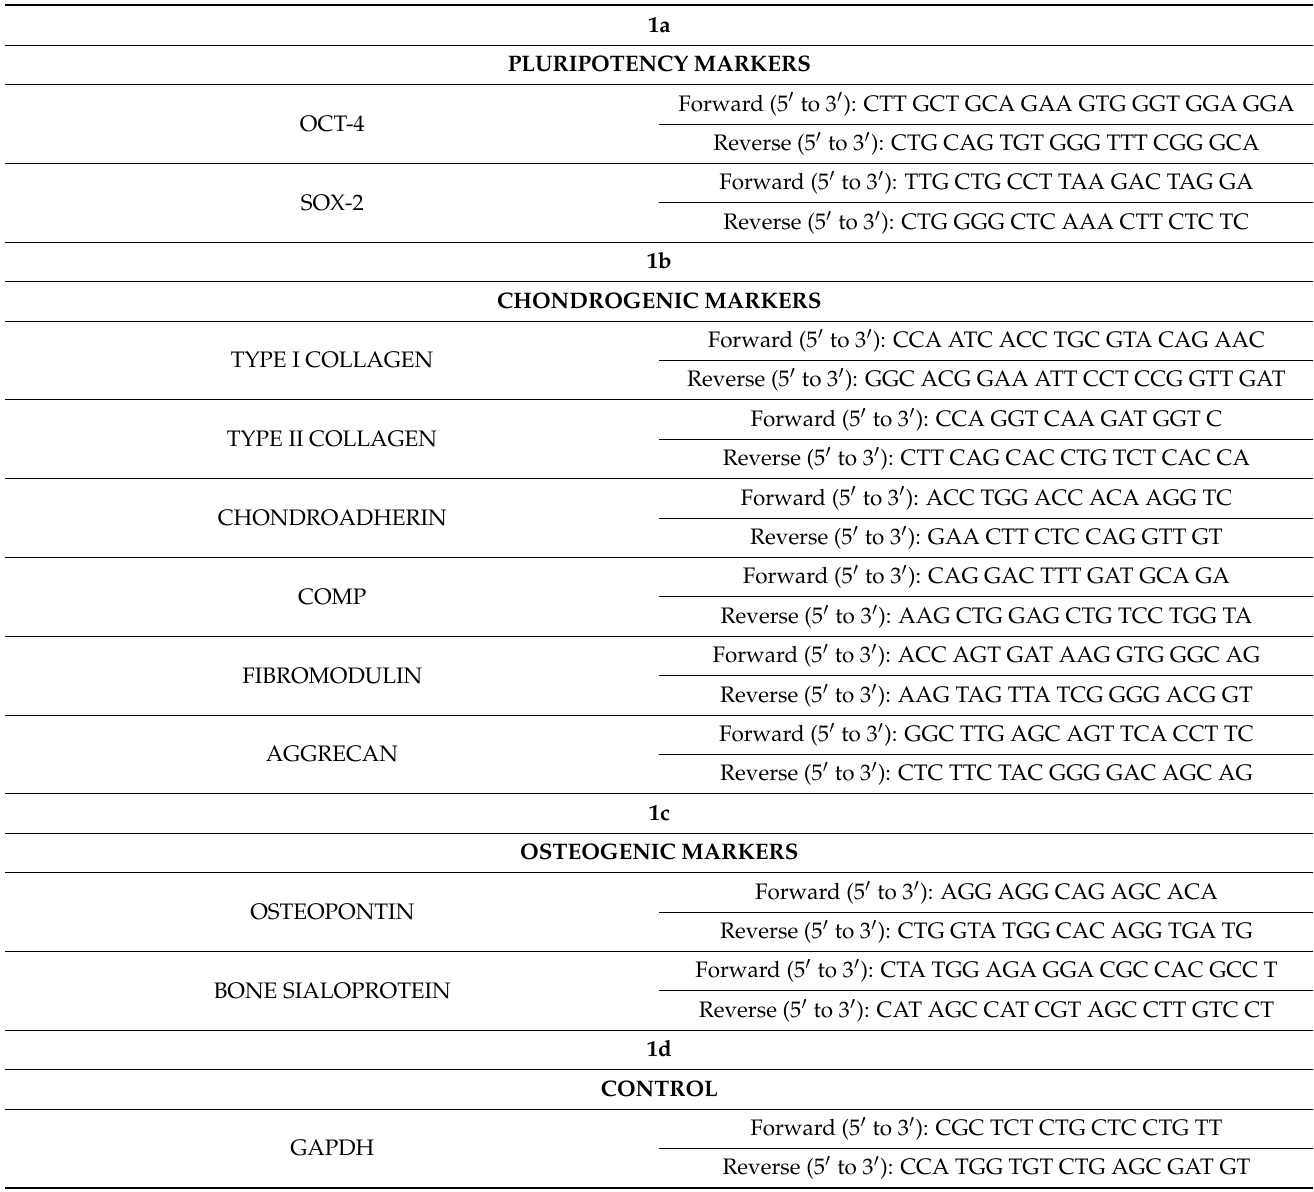
Table 1. Primer sequences for pluripotency markers (1a), chondrogenic markers (1b), osteogenic markers (1c), and the control sequence